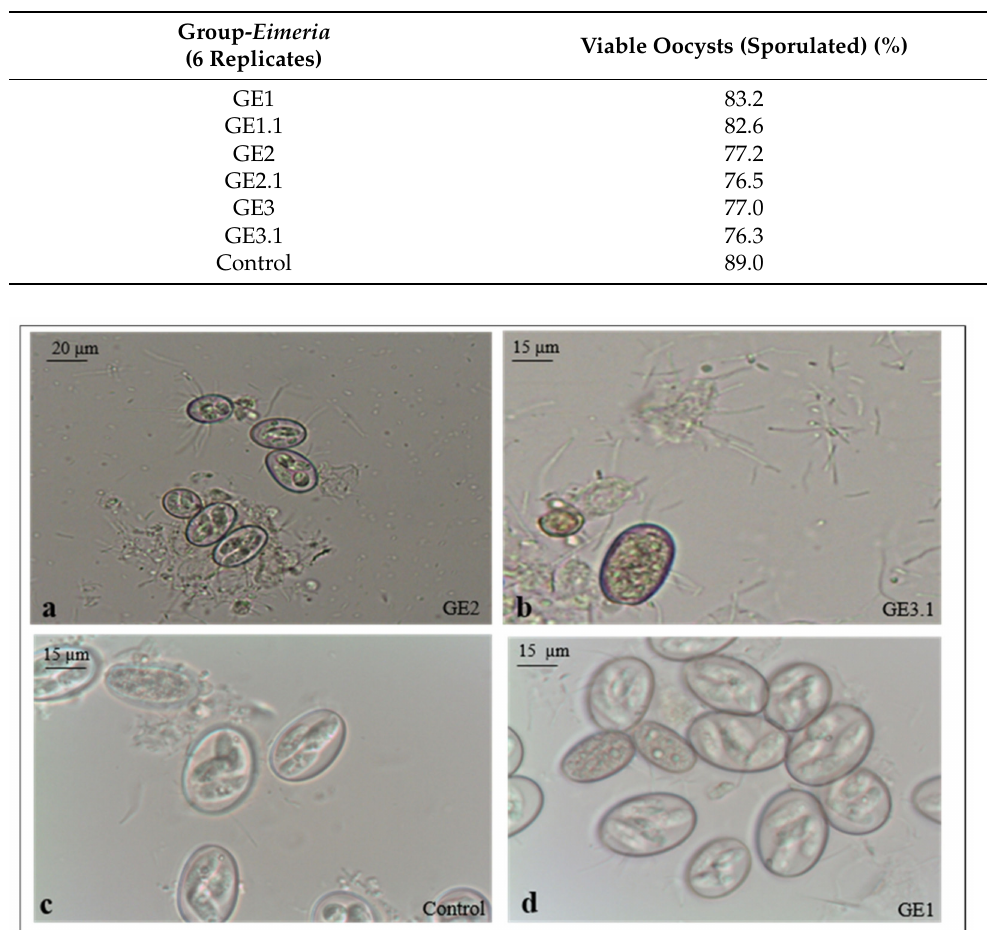
Table 3. The sporulation rate of the Eimeria spp. oocysts treated with ozonated water.